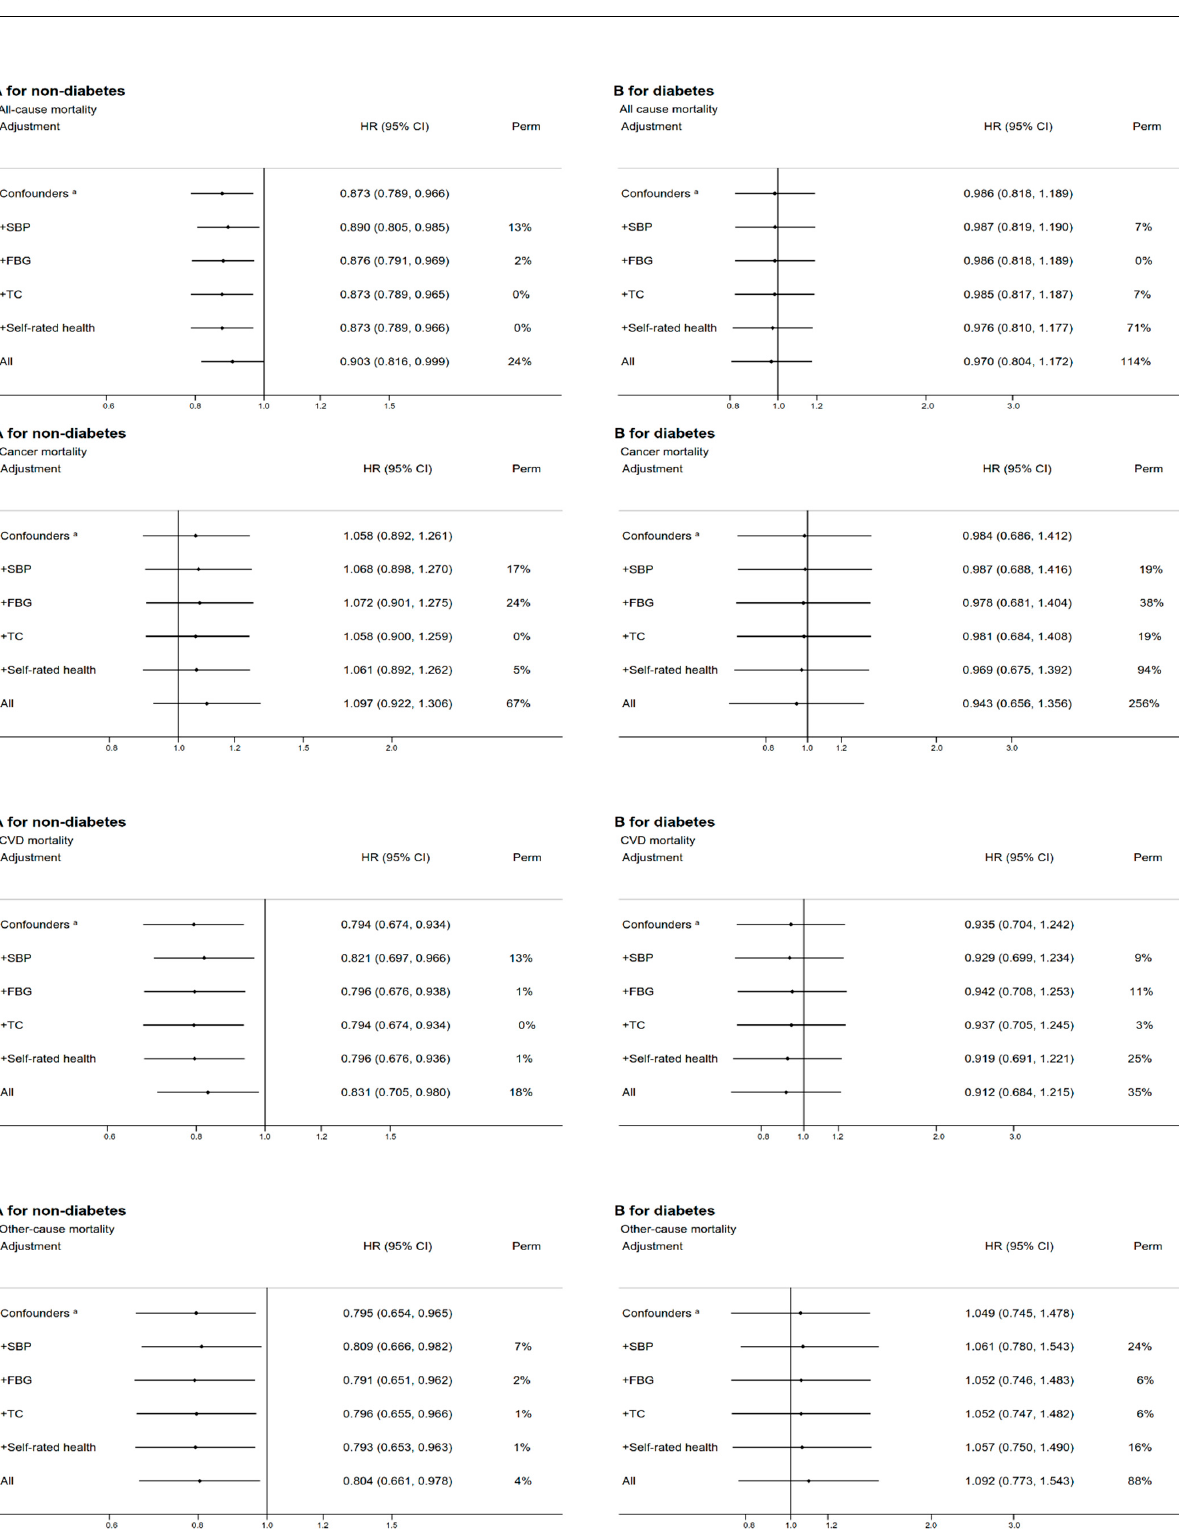
Figure 3. The associations between the meat-based LCD score (Q4 versus Q1) and mortality, and the proportions of the associations attributable to systolic blood pressure, fasting plasma-glucose, total cholesterol, and self-rated health ( A : participants without diabetes, B : participants with diabe- tes).